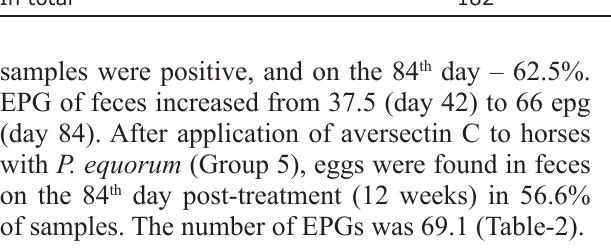
Table-1: Distribution of horse nematode in central Russia (n = 280). Nematode Number of positive samples With eggs, % Strongylidae gen.